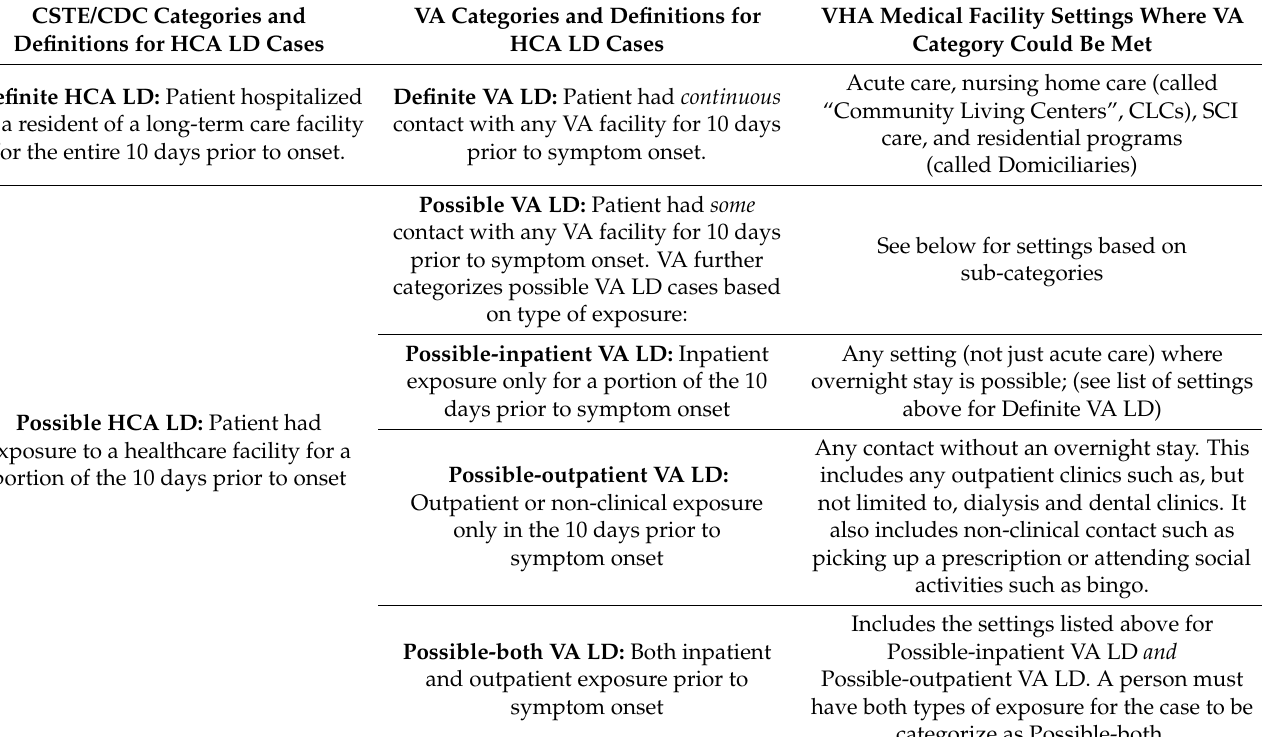
Table 1. VA Legionella disease case classification categories and definitions used for reporting HCA LD cases a by VHA medical facilities for cases prior to